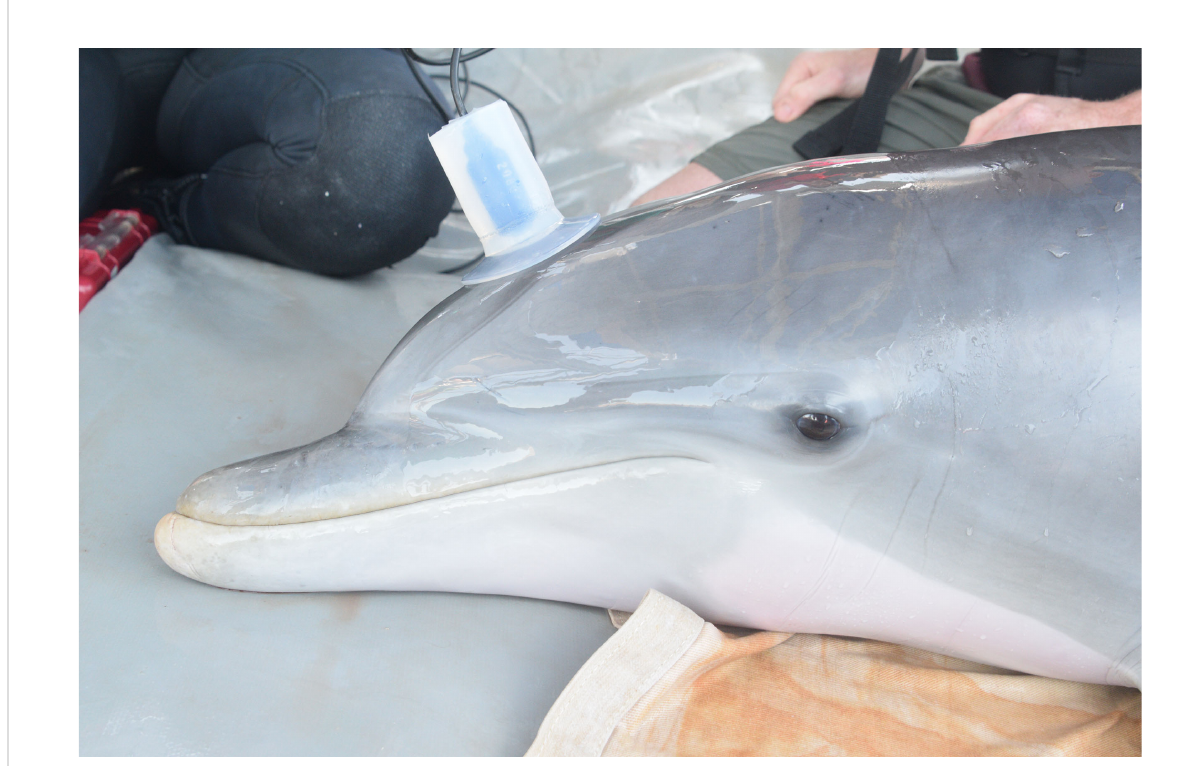
FIGURE 1 Common bottlenose dolphin being recorded with a suction-cup hydrophone directly on the melon, while being temporarily held during health assessments in Sarasota Bay, Florida. Photo taken by the Chicago Zoological Society ’ s Sarasota Dolphin Research Program under NOAA/ National Marine Fisheries Service Scienti fi c Research